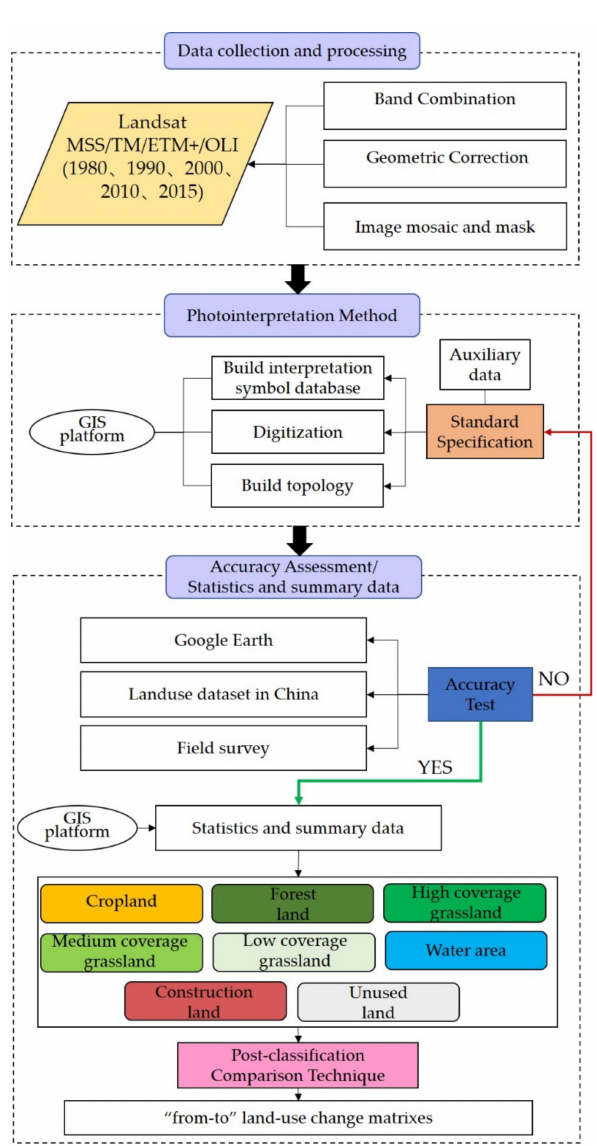
Figure 2. The flow chart of data processing in this